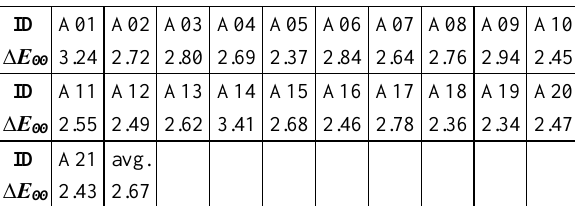
Table 3. Colour error parameter (∆E 00 ) values for the Celebratory Aedicule in Study Case No. 3.